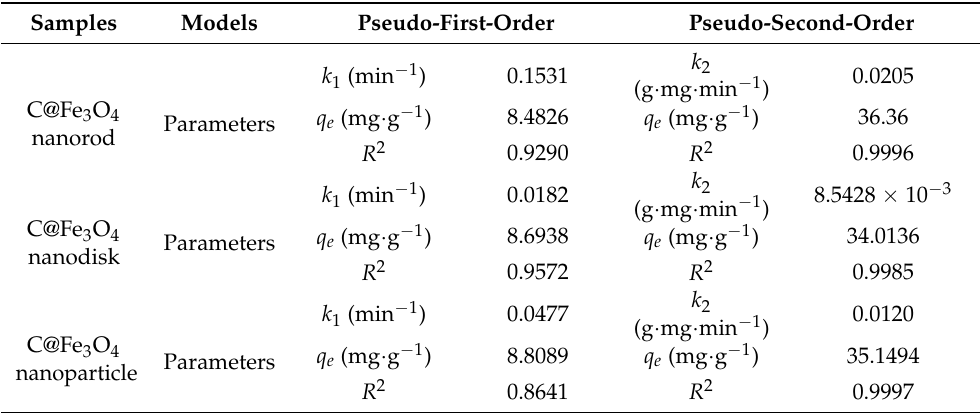
Figure 9. ( a ) Plot of log( q e − q t ) vs. t for the adsorption of MB onto the C@Fe 3 O 4 composites by using the pseudo-first-order kinetic model; ( b ) plot of t / q t vs . t for the adsorption of MB onto C@Fe 3 O 4 composites by using the pseudo-second-order kinetic model (inset: t / q t vs . t for adsorption of MB onto C@Fe 3 O 4 composites in 30 min ); ( c ) plot of q t vs . t 1/2 for the adsorption of MB onto C@Fe 3 O 4 composites; ( d ) plot of Bt vs . t for the adsorption of MB onto C@Fe 3 O 4 composites (scatter plots represent the adsorption data and the lines are the fitting curves based on the four kinetic models). Table 2. Parameters of pseudo-first-order and pseudo-second-order for the adsorption of MB onto the C@Fe 3 O 4 composites.